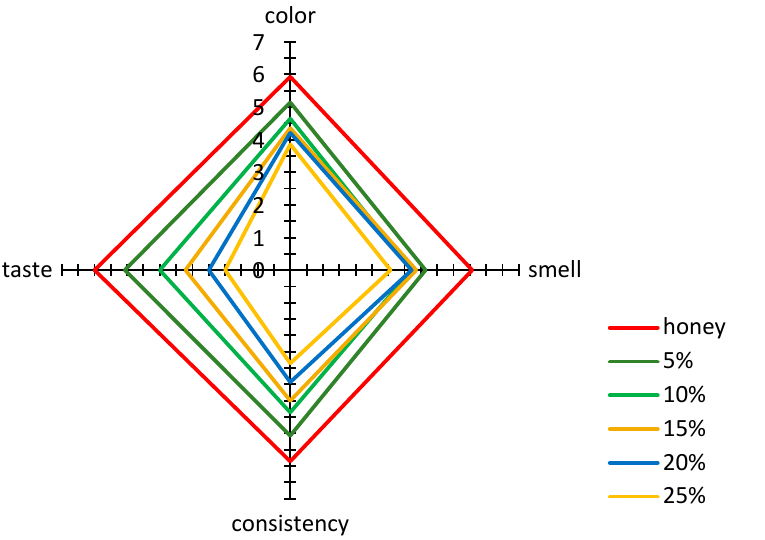
Figure 2. Results of the acceptability evaluation of multiflower honey and honey samples enriched with bee pollen.